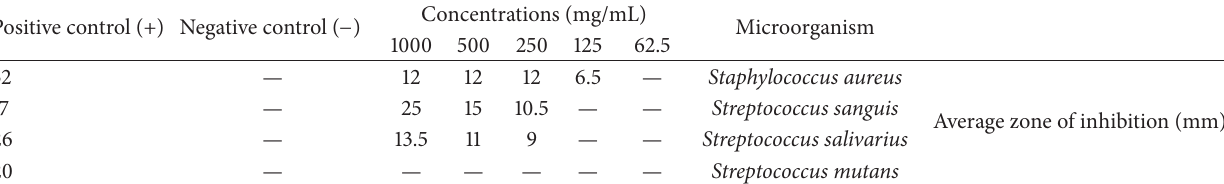
Table 1: Average of inhibition zone of aqueous extract on some oral bacteria (mm).